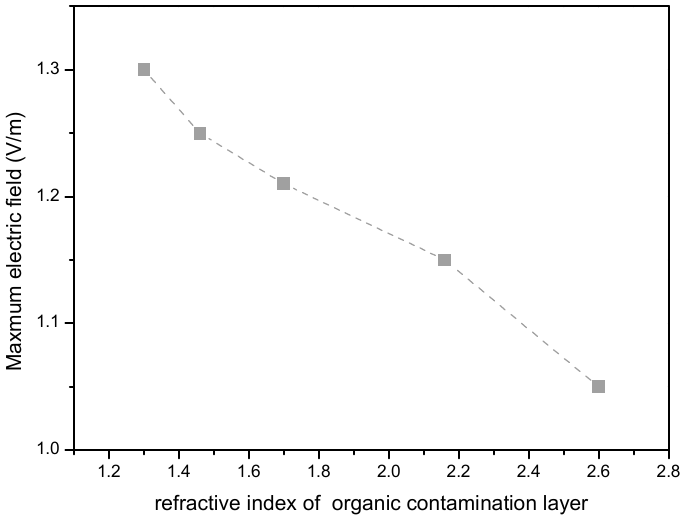
Figure 6. Light field variation with an organic contamination layer of different refractive indexes (the refractive index of the defect is 1.5).